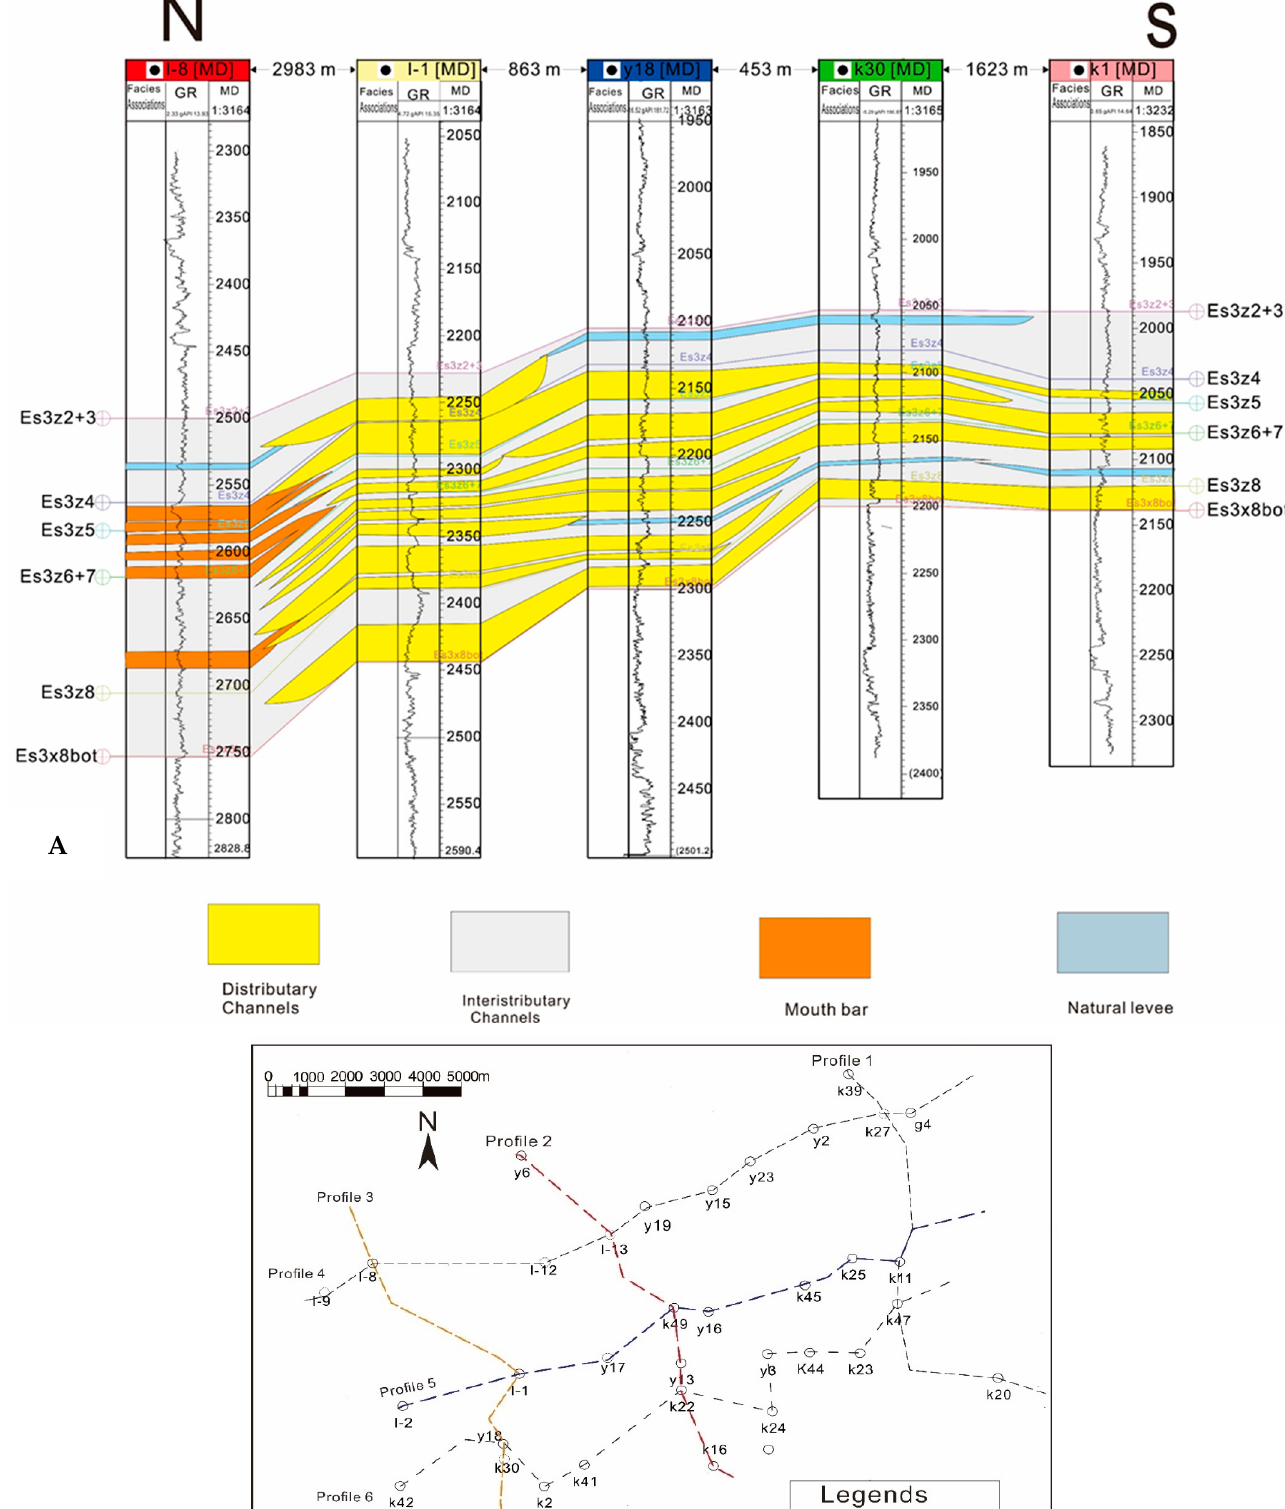
Figure 14. ( A ) Cross section profile 3 of facies associations in five sandstones group, showing facies to facies correlations from south to north. ( B ) Cross section of all profiles.